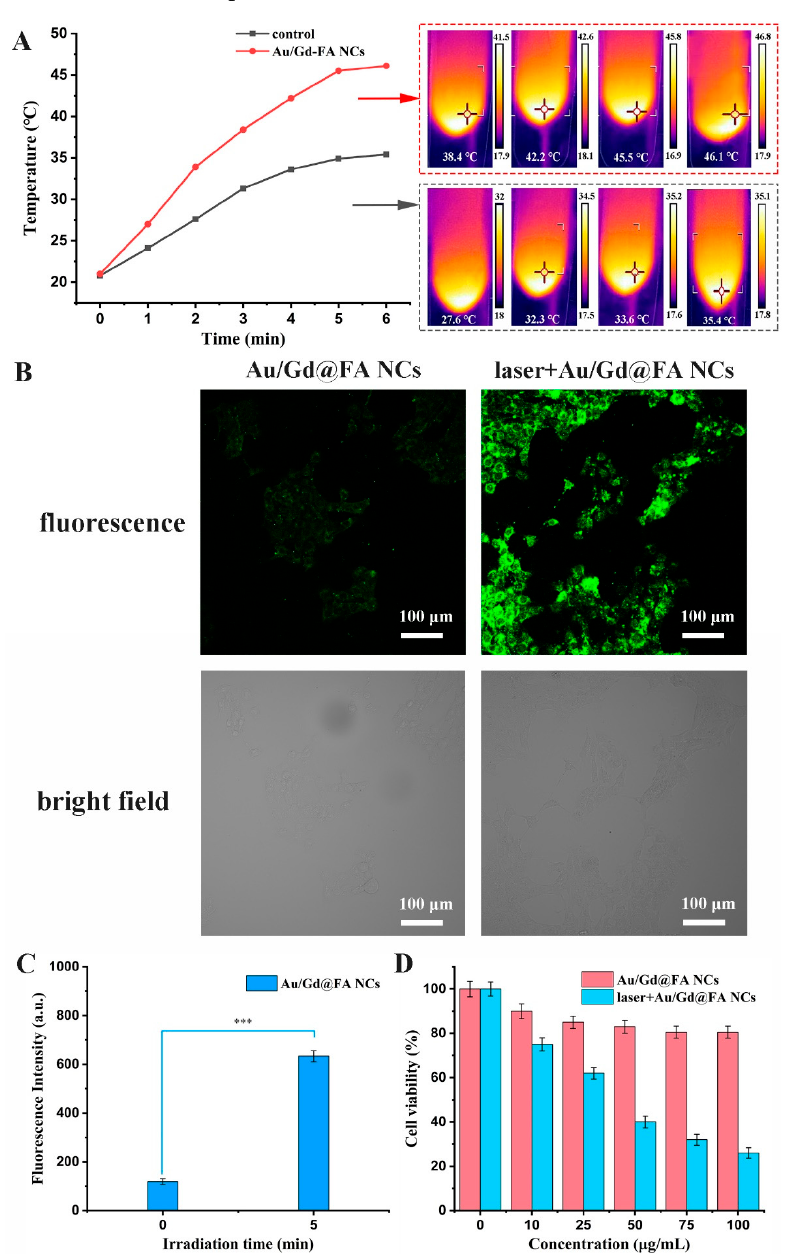
Figure 7. ( A ) Photothermal capacities of Au/Gd@FA NCs with 660 nm laser irradiation (1.2 W/cm 2 ) for 6 min in control (PBS) and with Au/Gd@FA NCs (60 μ g/mL) solution. ( B ) Intracellular ROS formation of 4T1 cells incubated with Au/Gd@FA NCs without or with 660 nm laser irradiation (1.2 W/cm 2 ). ( C ) Histogram of fluorescence intensity analysis of intracellular ROS, *** p < 0.001. ( D ) Cell viability of 4T1 cells incubated with Au/Gd@FA NCs without or with 660 nm laser irradiation (1.2 W/cm 2 ).